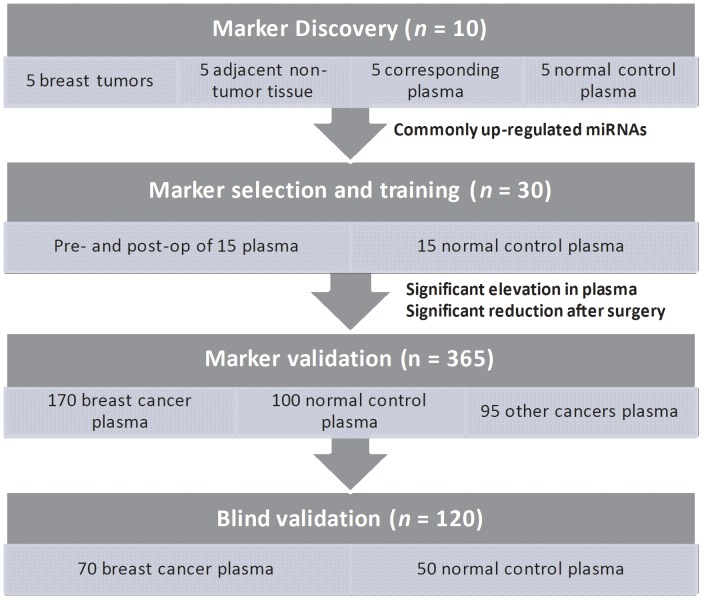
Schematic diagram of the workflow of this study.